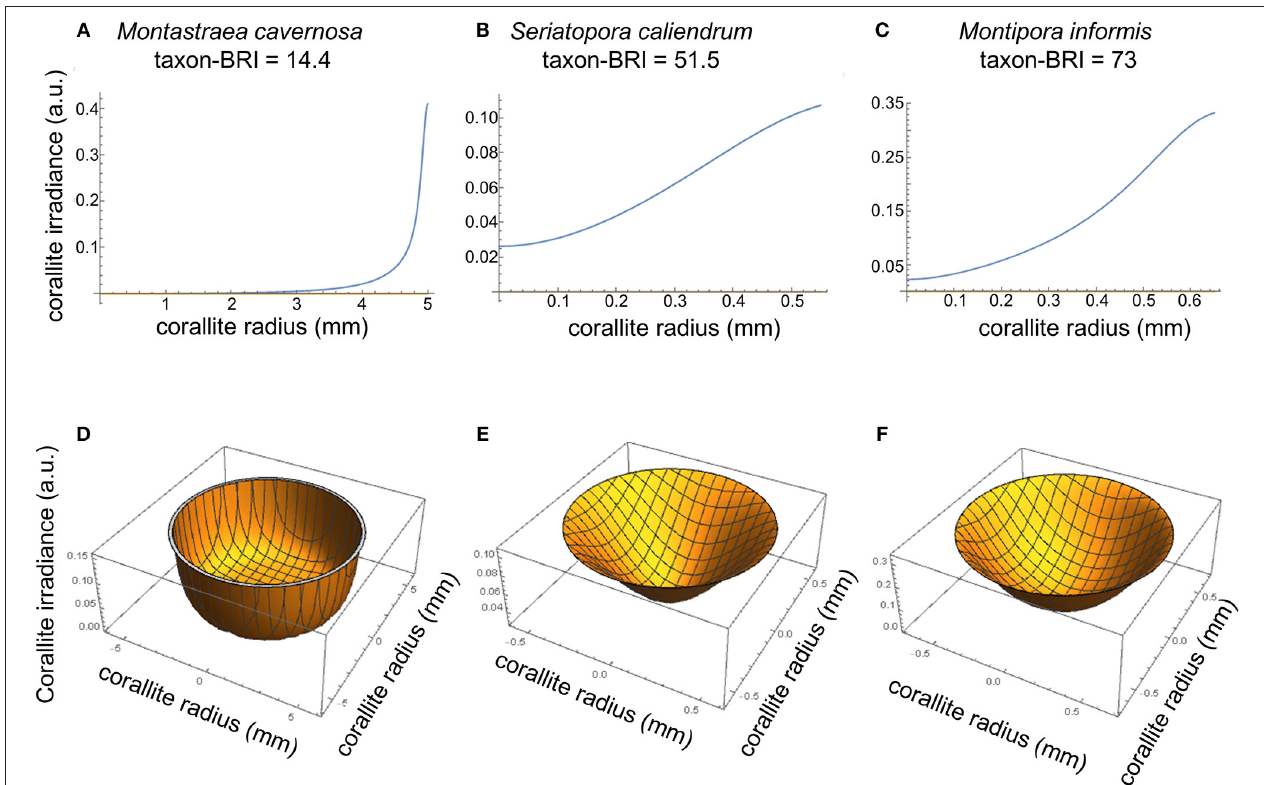
FIGURE 3 | Modeled irradiance at the corallite surface for M. cavernosa (A,D) , S. caliendrum (B,E) and M. informis (C,F) with increasing bleaching susceptibility scores (taxon-BRI of 14.4, 51.5, and 73, respectively) and differential ETD coenosteum and light scattering properties of both corallites and coenosteum (see Figure 2 and Table S3 ). Plots of 2-D cross-sections through the middle of corallites (A–C) and 3-D top view cross-section representations of modeled irradiance in corallites due to light transport in the coenosteum (D–F) . The irradiance reaching the corallite was modeled as a function of the size of the corallite (mm), intercorallite distance (mm), and light scattering coefficient ( µ s ′ ) of corallite and coenosteum (equations